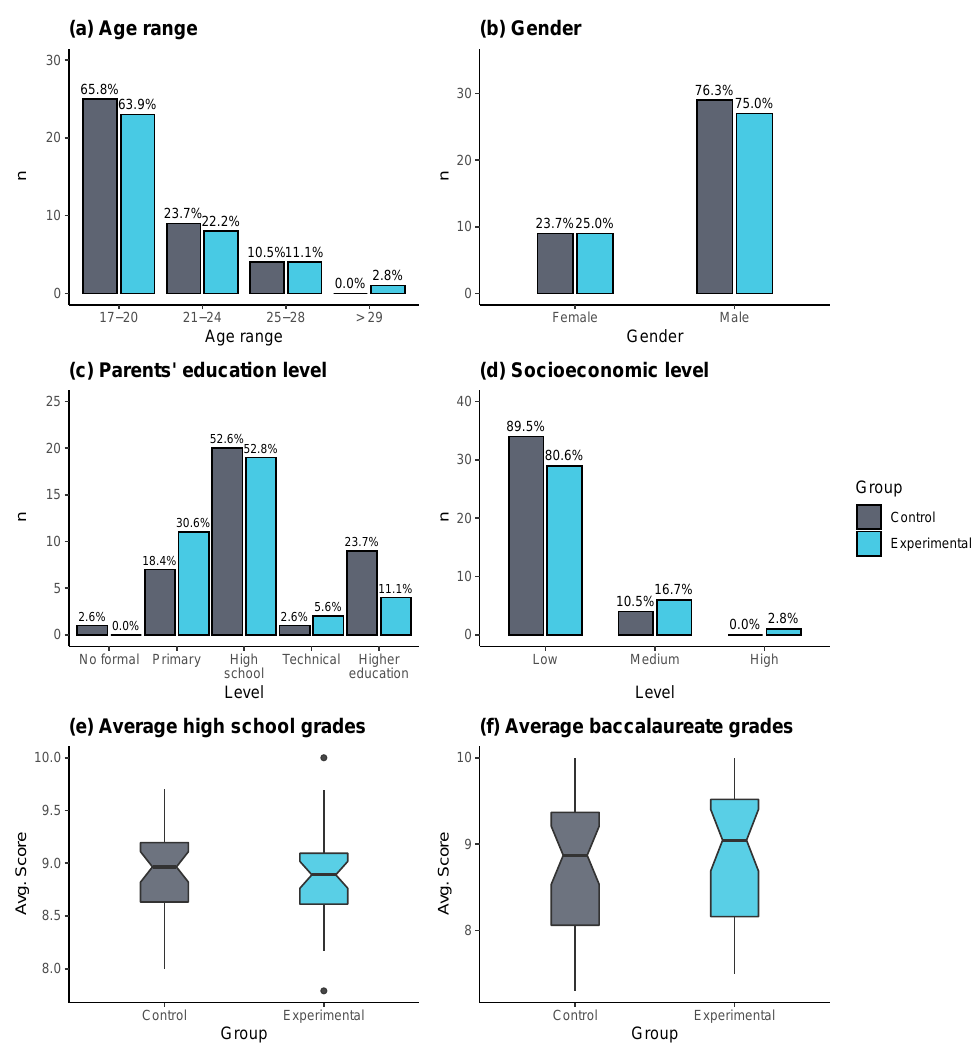
Figure 2. Descriptive summary of the students’ characteristics for variables: age ( a ), gender ( b ), parental education level ( c ), socioeconomic level ( d ), previous high school grades ( e ), and previous baccalaureate grades ( f